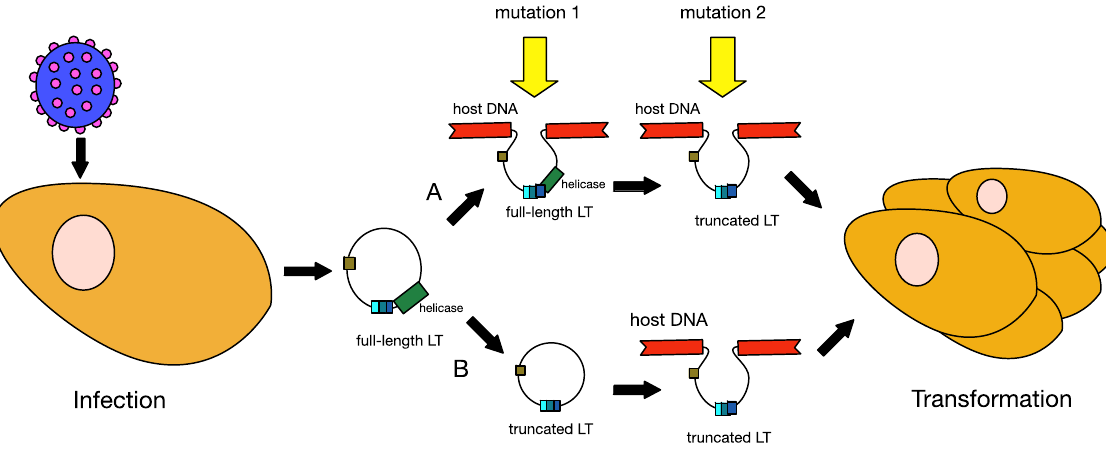
Figure 7. Models of MCPyV-induced MCC tumourigenesis. MCPyV infection is